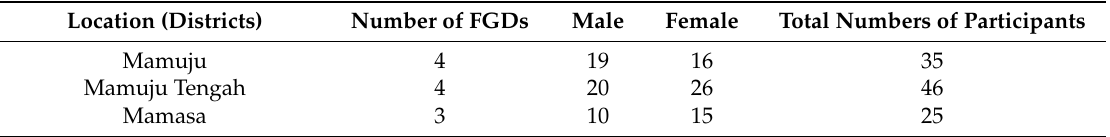
Table 1. Details of Focus Group Discussions (FGDs), location and